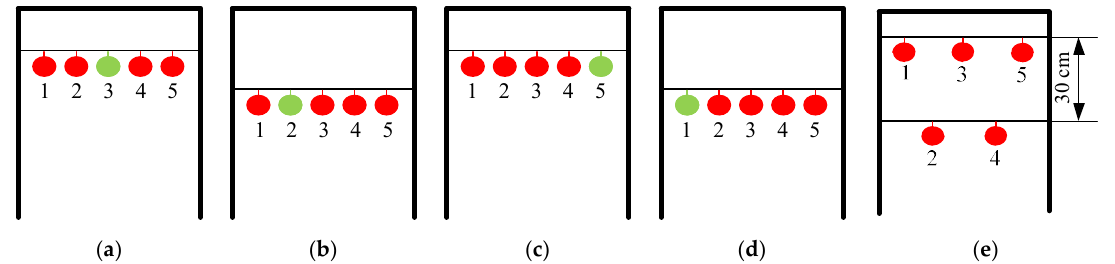
Figure 24. ( a ) Schematic diagram of Fruit hanging I; ( b ) Schematic diagram of Fruit hanging II; ( c ) Schematic diagram of Fruit hanging III; ( d ) Schematic diagram of Fruit hanging IV; ( e ) Schematic diagram of Fruit hanging Table 5. Experimental data.